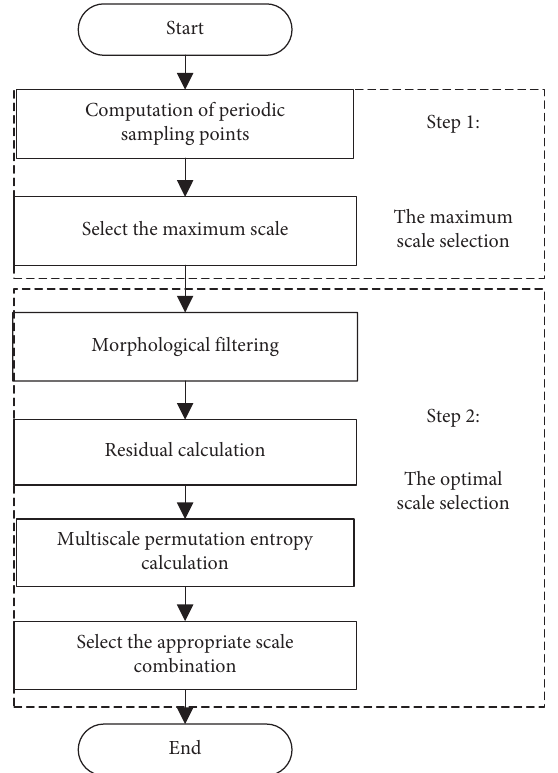
Figure 4: Flowchart of the optimal scale combination